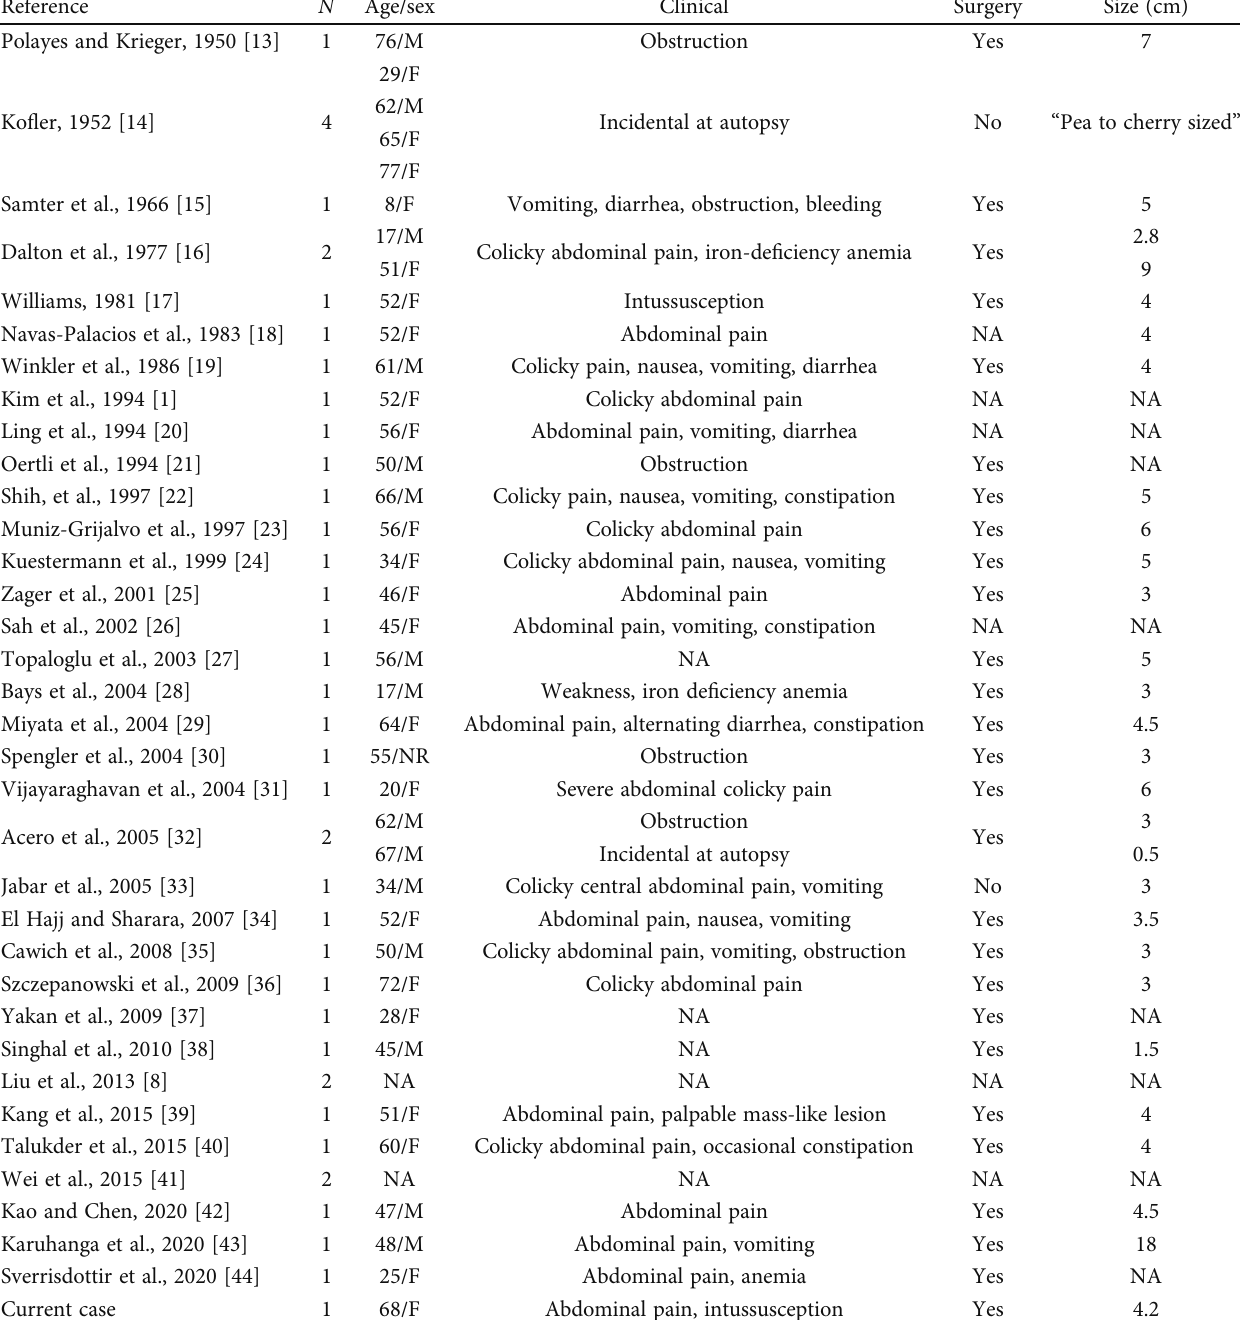
Table 1: In fl ammatory fi broid polyps of the jejunum: cases published between 1950 and the present (including current case).